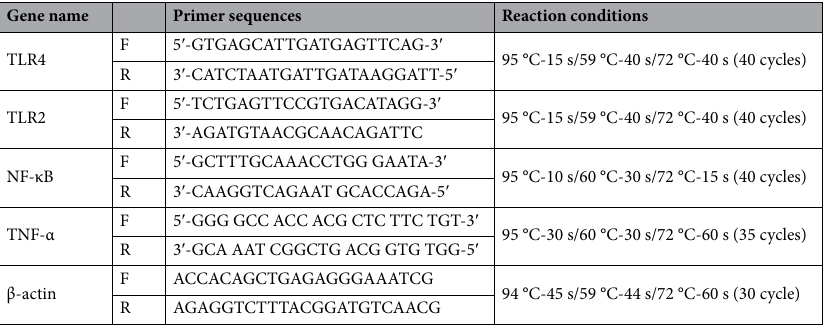
Table 1. Oligonucleotide primer sequences and real-time PCR conditions. F forward primer, R reverse primer, TLR4 toll-like receptors 4, TLR2 toll-like receptors 2, NF-kB nuclear factor-kappa B, TNF-α tumor necrosis